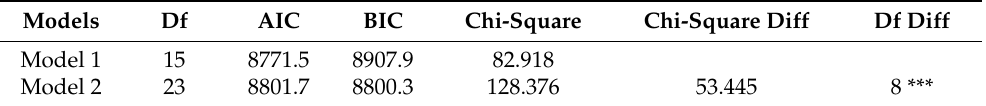
Table 3. Comparison data between